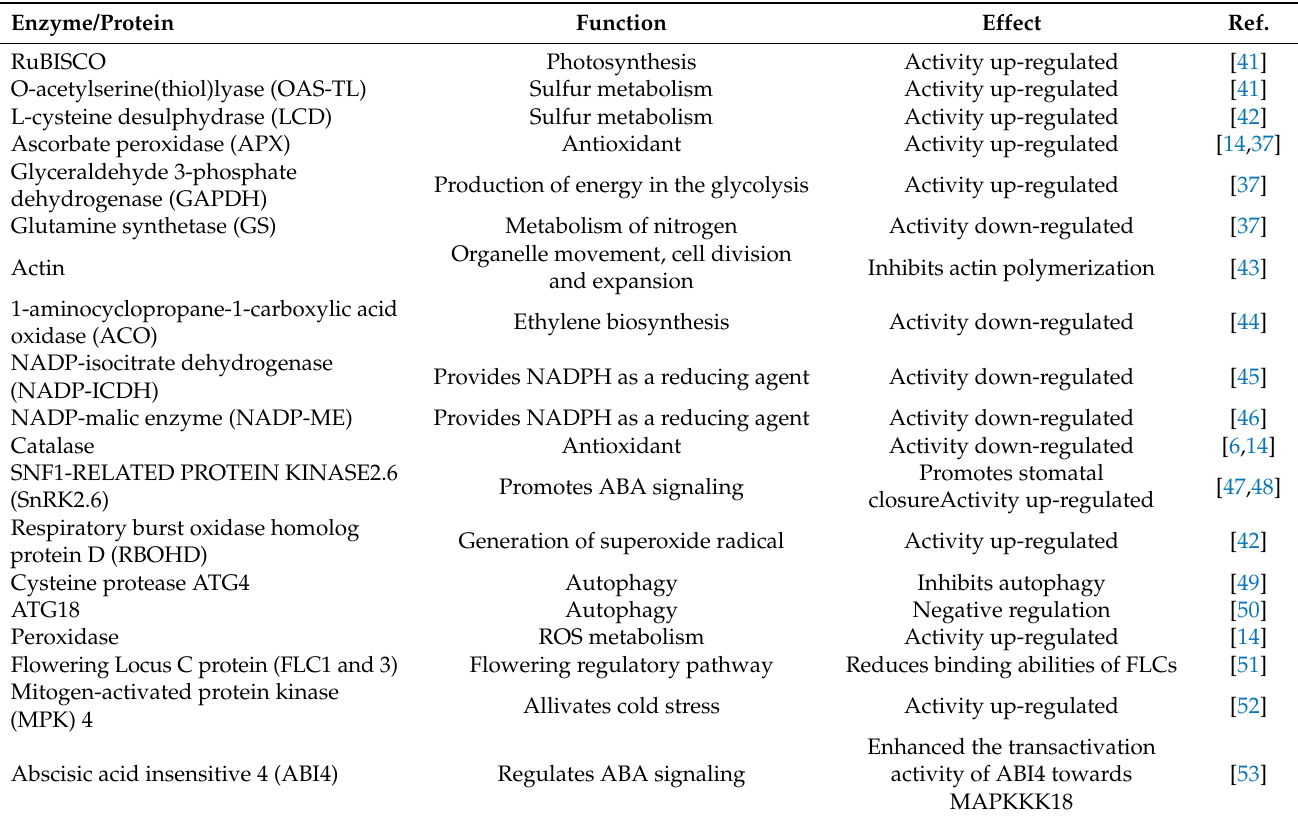
Table 1. Identified plant protein targets of persulfidation whose function is positive or negatively affected by H 2 S.